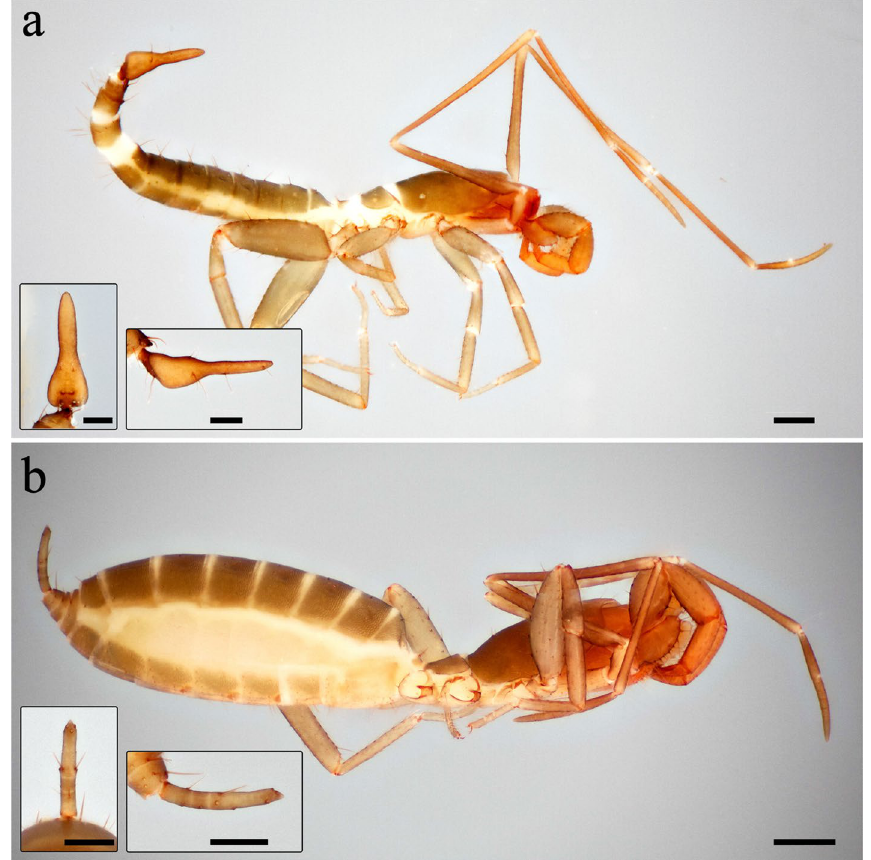
Figure 1. Habitus and flagellum images of Hubbardia pentapeltis Cook, 1899. ( a ) Male (USNMENT 1538005), lateral; inset left, flagellum in dorsal view; inset right, flagellum in lateral view. ( b ) Female (USNMENT 1458794), lateral; inset left, flagellum in dorsal view; inset right, flagellum in lateral